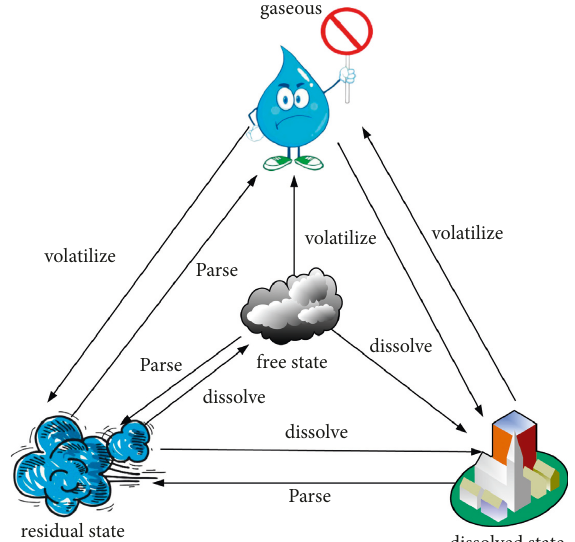
Figure 5: Transformation of